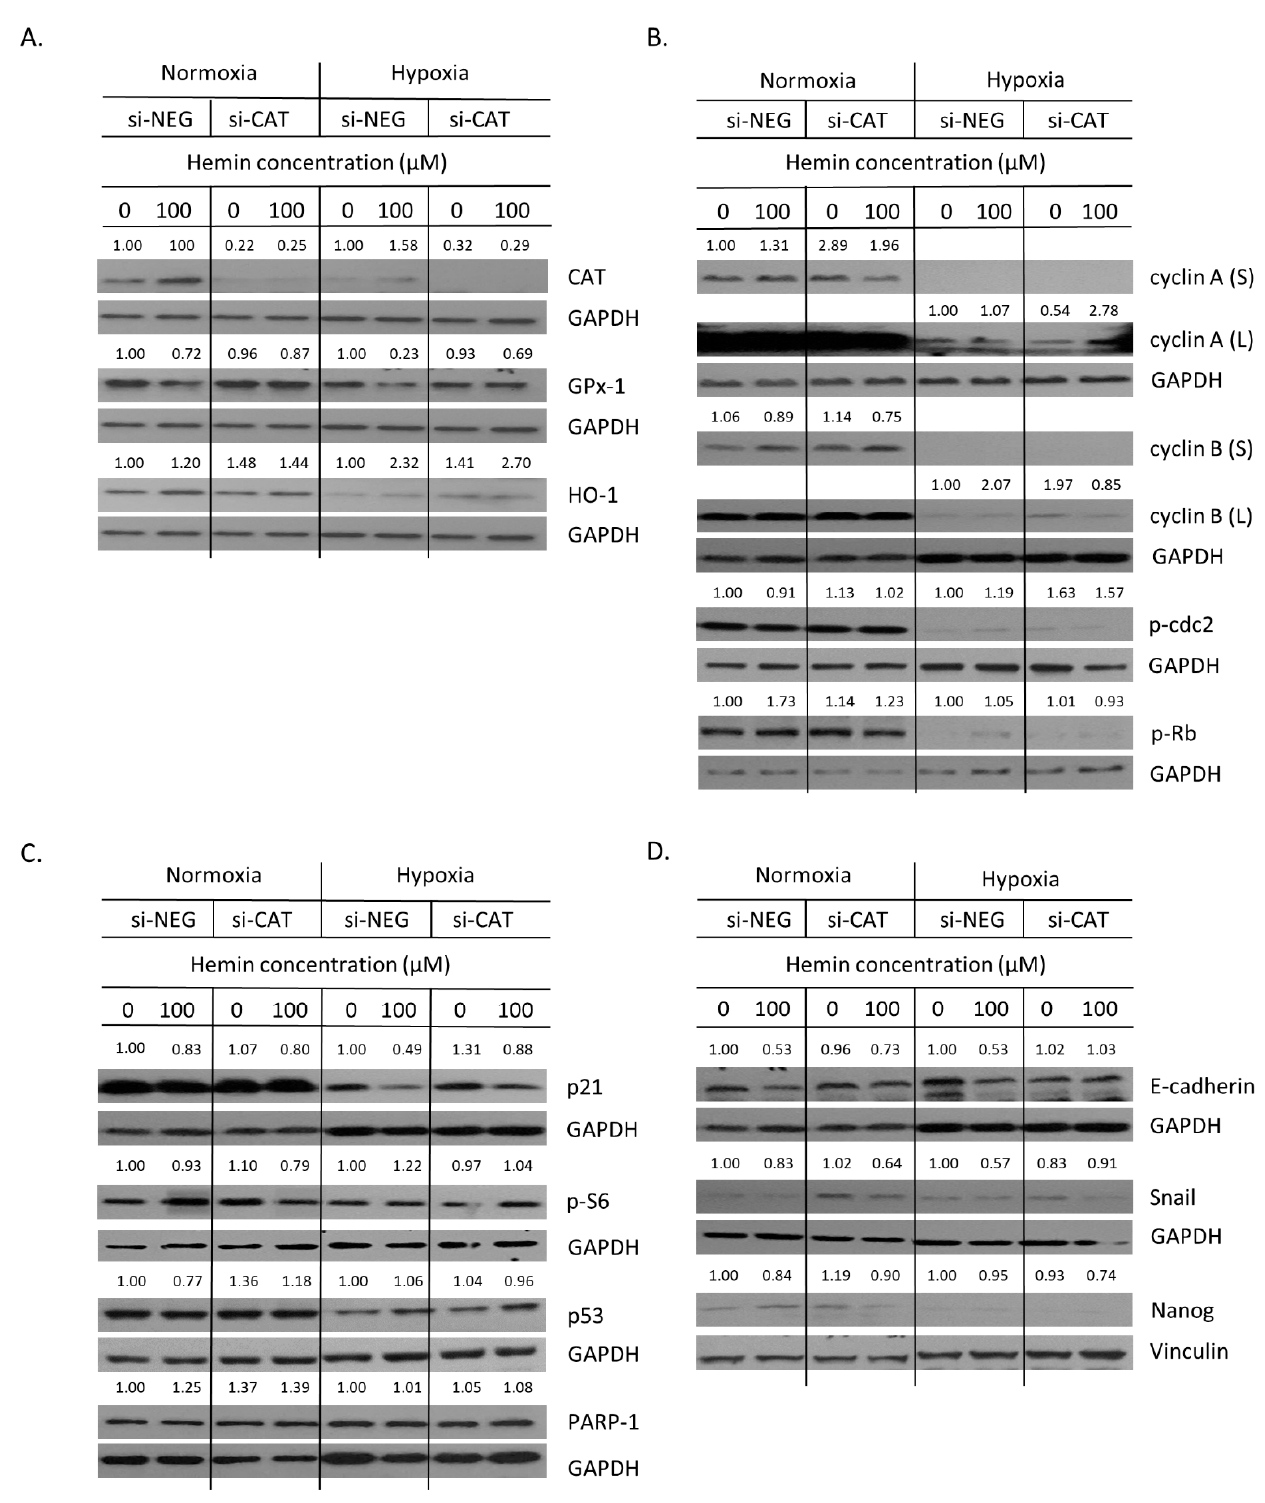
Figure 9. Hemin enhances escape from senescence in hypoxic cells in the presence of CAT: changed the expression of proteins related to proliferation and EMT. In HCT116 cells, the gene encoding CAT was silenced with the use of siRNAs. Cells were cultured in parallel in normoxia or hypoxia. Cells were exposed to 100 µM hemin ( □ ). Control cells were subjected to IRINO and NaOH in the corresponding dose ( ■ ). ( A ) Production of antioxidative enzymes. Representative blots show levels of CAT, GPx-1, and HO-1 proteins. ( B ) Production of proteins related to cell cycle progression. Representative blots show levels of cyclin A, cyclin B, p-cdc2, and p-Rb. ( C ) Production of protein related